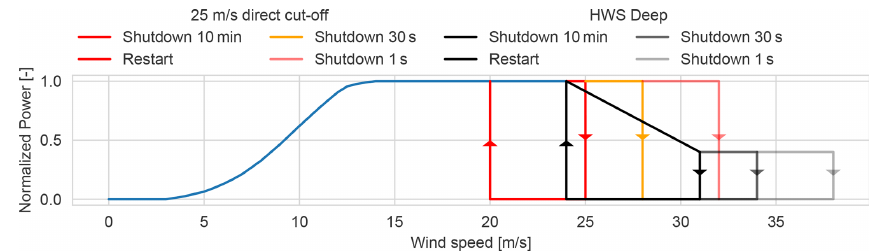
Figure 4. Single-turbine storm shutdown for the three high-wind-speed operation technologies.